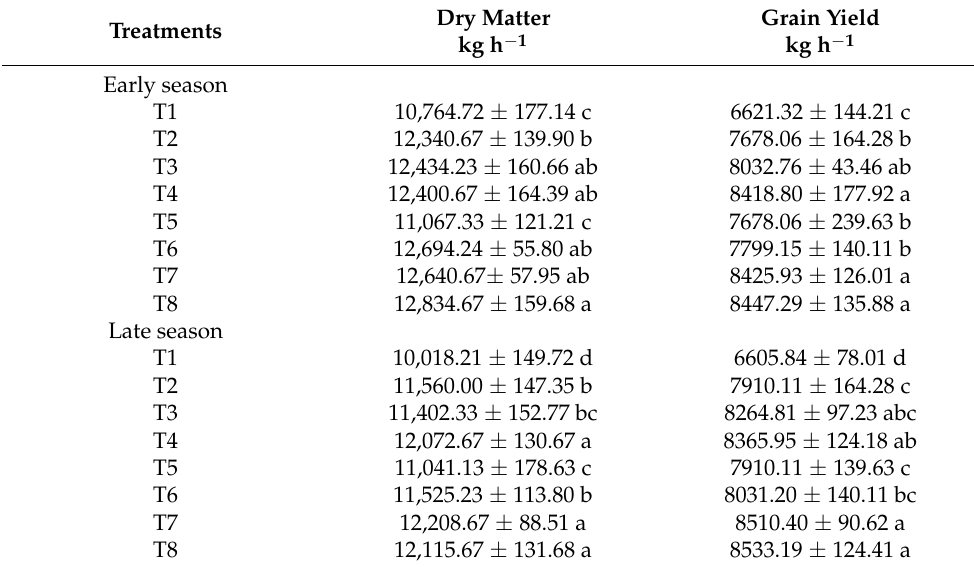
Table 4. Dry matter production and grain yield under low- and high-dose urea application and different rates of biochar